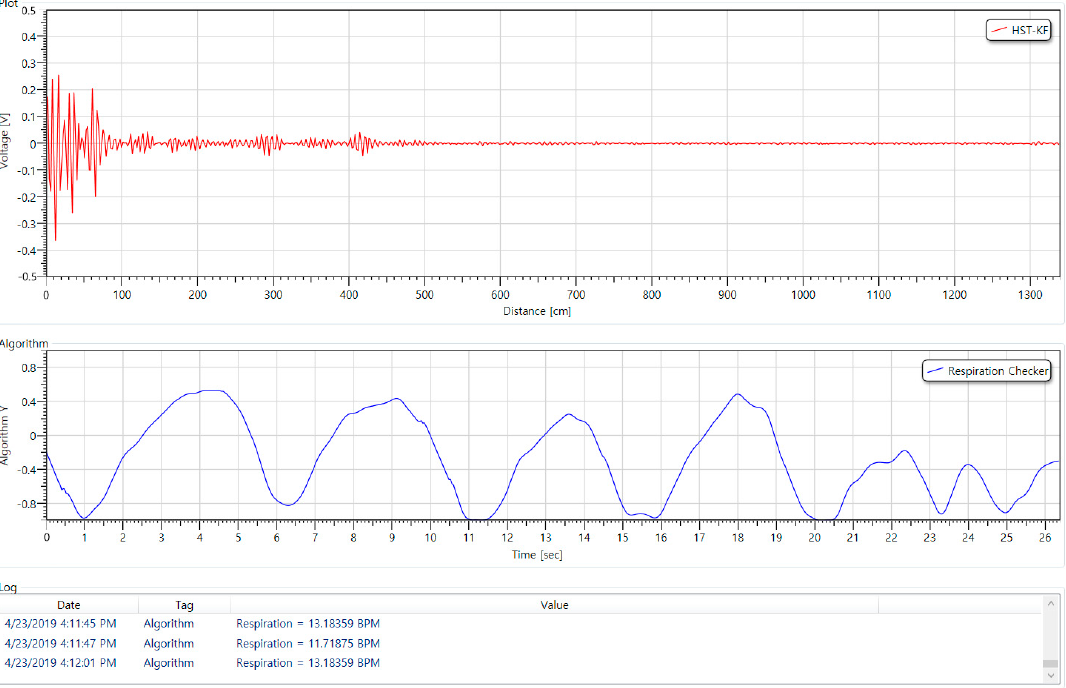
Figure 10. UWB Radar PC program for extracting respiratory signal data.